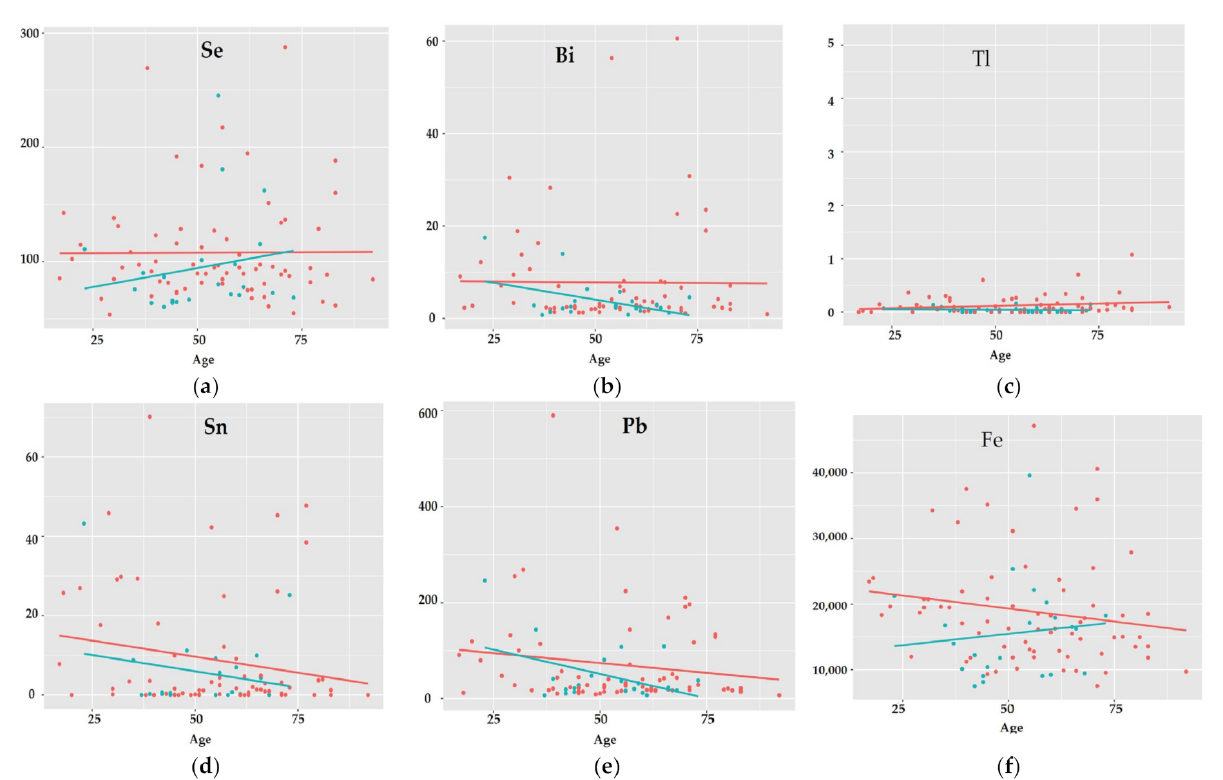
Figure 6. The trends of changes occurring in the concentration of elements (ppb): Se ( a ), Bi ( b ), Tl ( c ), Sn ( d ), Pb ( e ), Fe ( f ) in the optic chiasm with age for the control group—without AUD (red points, red line) and the test group with AUD (green points, green